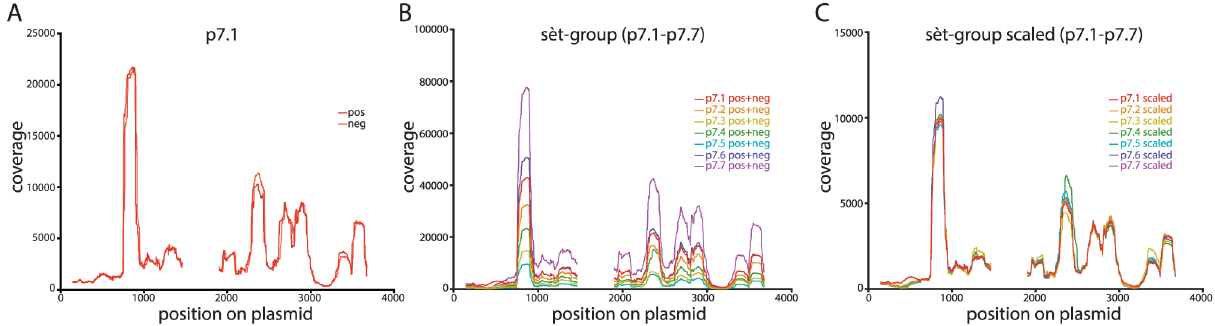
Figure 2. Invitrosome coverage plots for an alternative plasmid backbone (the se`t-group plasmids) also show near identical coverage patterns. 2A Example coverage plot for one of the se`t-group plasmids (p7.1) with both forward (pos) and reverse (neg) invitrosomes plotted separately on the same graph. 2B Non-scaled coverage plots with forward and reverse invitrosomes (pos + neg) combined for each of the seven se`t-group plasmids plotted on the same graph. 2C Combined and scaled coverage plots for all seven se`t -group plasmids, where for direct comparison, each plot is normalized to the plasmid with the least coverage and plotted on the same graph.